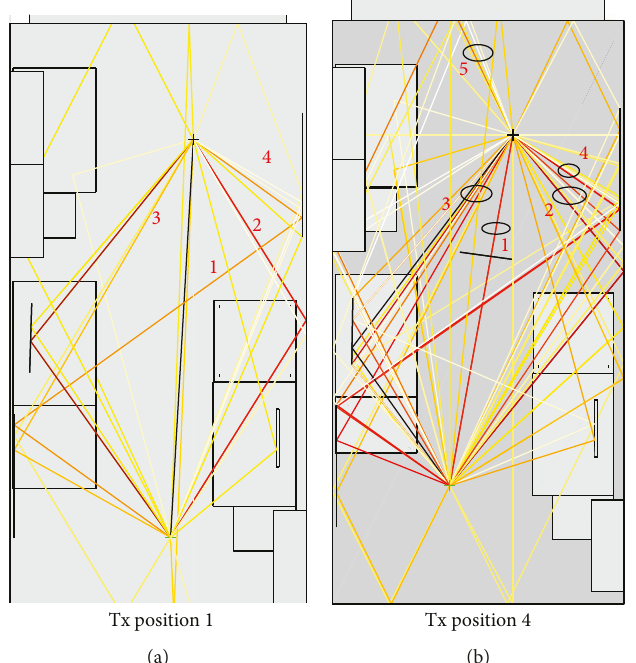
Figure 17: Ray trajectories of the multipath components for Tx position 1 in the LOS scenario (a) and Tx position 4 (b) in the obstructed LOS scenario in the small o ffi ce.